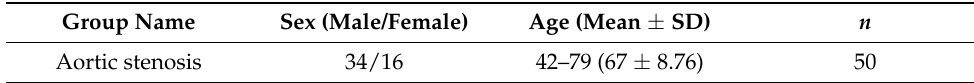
Table 1. Demographics of studied individuals ( n =